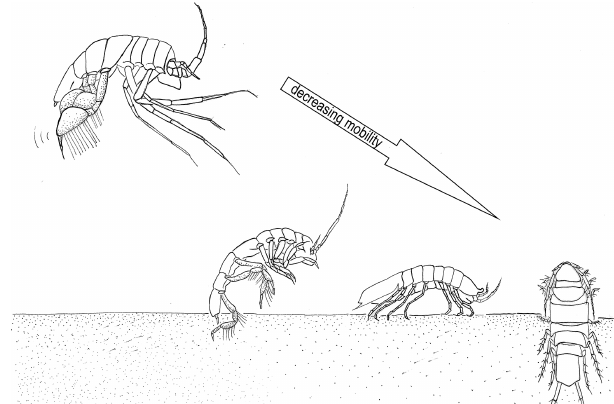
Figure 2. Illustration of the locomotion of the four isopod families. From right to left decreasing mobility: Munnopsidae – swimming; Desmosomatidae – walking/swimming; Haploniscidae – walking; and Macrostylidae –